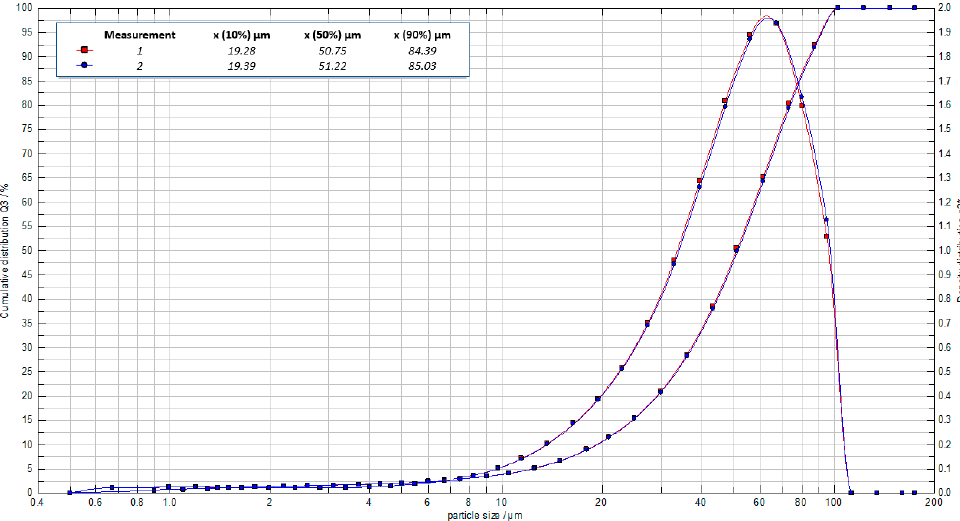
Figure 3. Particle size distribution of VIPS2 .